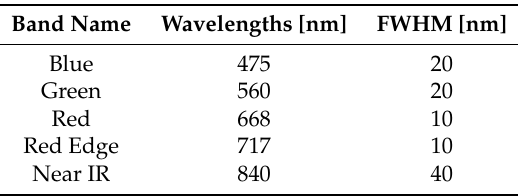
Table 1. MicaSense RedEdge spectral bands with respective center wavelengths and bandwidth